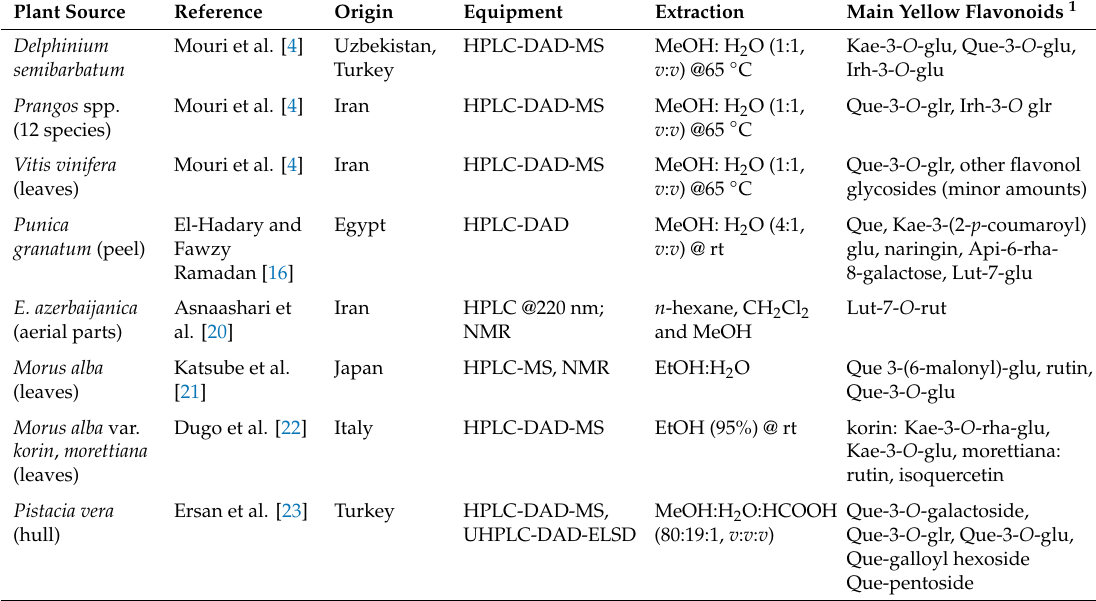
Table 1. Main components described in literature for the plant sources. Plant origin, analytical, and extraction methods are